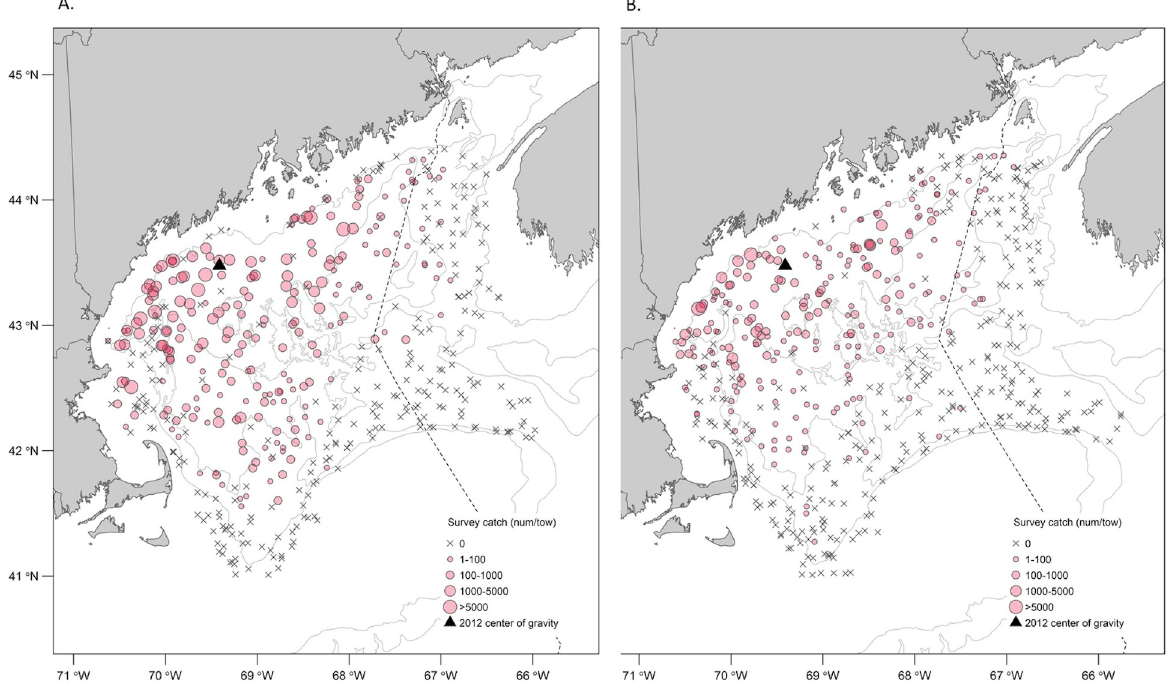
Fig 6. Number of northern shrimp per tow in fall surveys before and after the population collapse. (A.) 2006–2011; (B.) 2012–2017. Black triangle marks center of gravity in 2012.